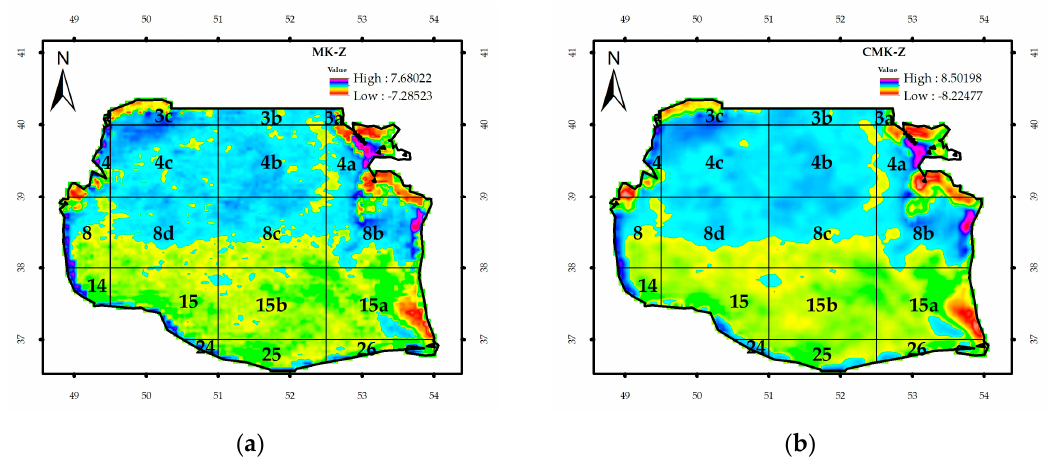
Figure 2. The Southern Caspian Sea (SCS) basin and impact of contextual information on significant trends before ( a ) and after ( b ) inclusion of contextual information.